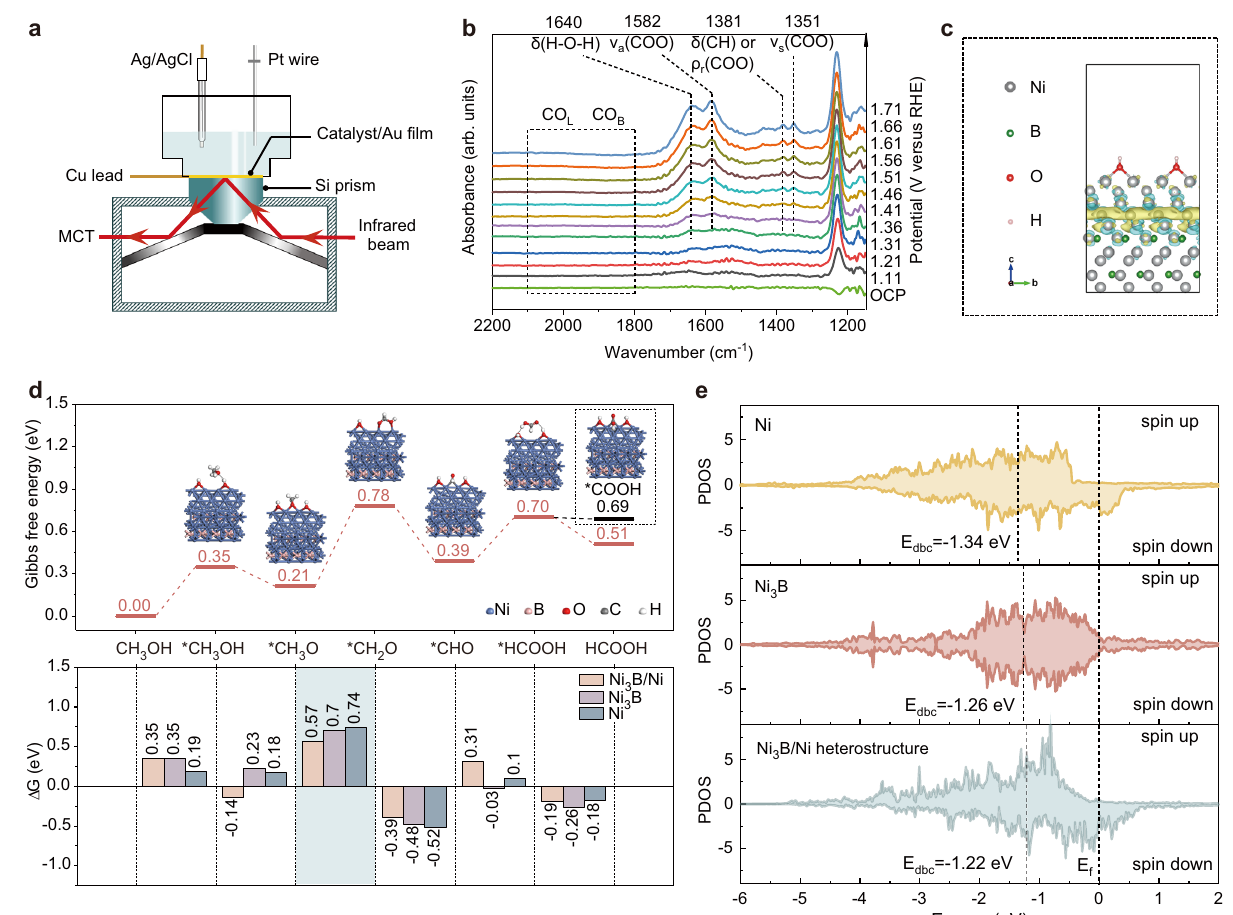
Fig. 6 | Reaction intermediates detection and DFT calculations. a Schematic diagram of the ATR-SEIRAS set-up. b ATR-SEIRAS spectra during MOR in 1M KOH containing 1M methanol electrolyte. c Differential charge density plot of nickel boride/nickel heterostructure. d Gibbs free energy diagram of MOR occurring on